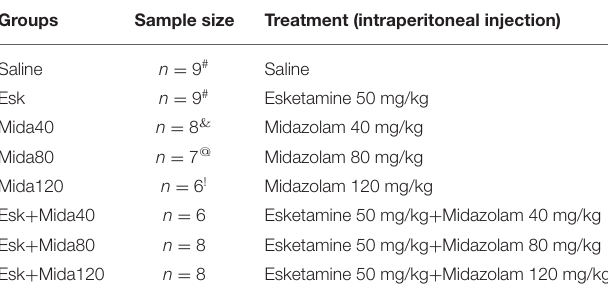
TABLE 1 | The details of the designed groups in this study.